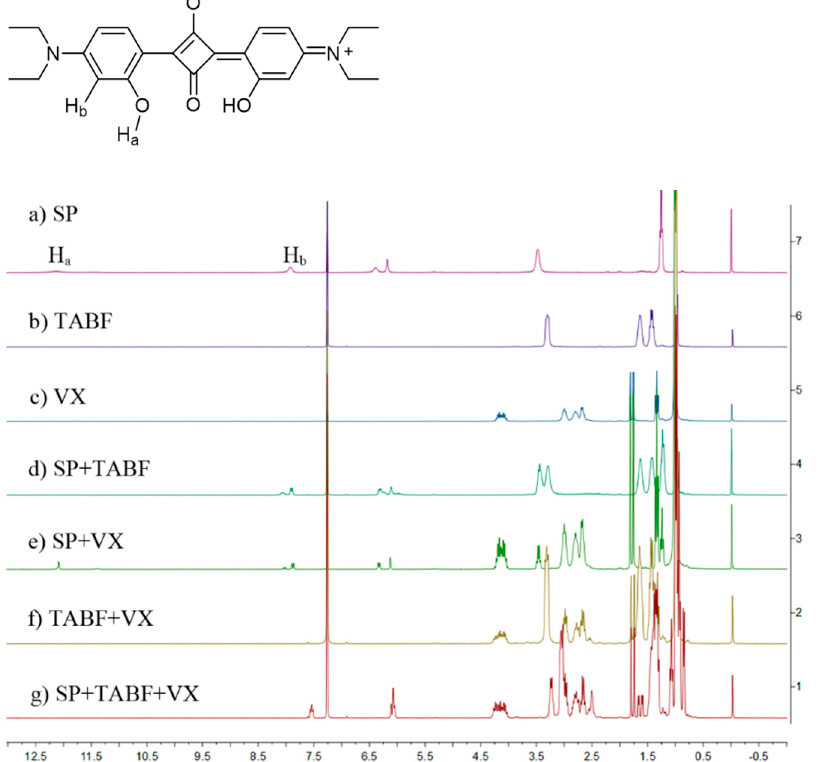
Figure 7. 1 H NMR spectra of the SP ( a ), TBAF ( b ), VX ( c ), the mixture of the SP with TBAF ( d ), the mixture of the SP with VX ( e ), the mixture of TBAF with VX ( f ), and the mixture of the SP with TBAF and VX ( g ).